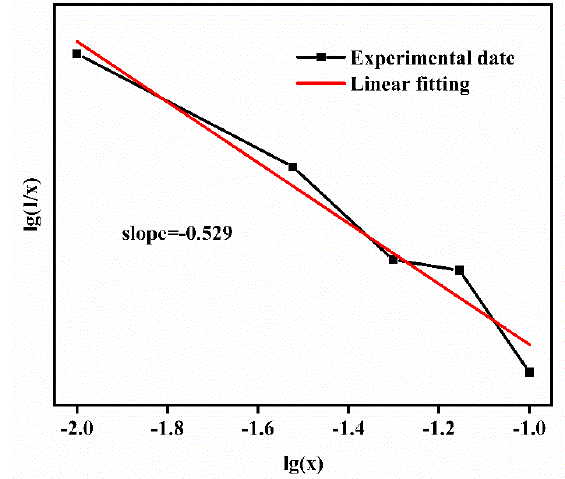
Figure 10. The dependence of lg(I / x) on lg(x) according to Equation (3).